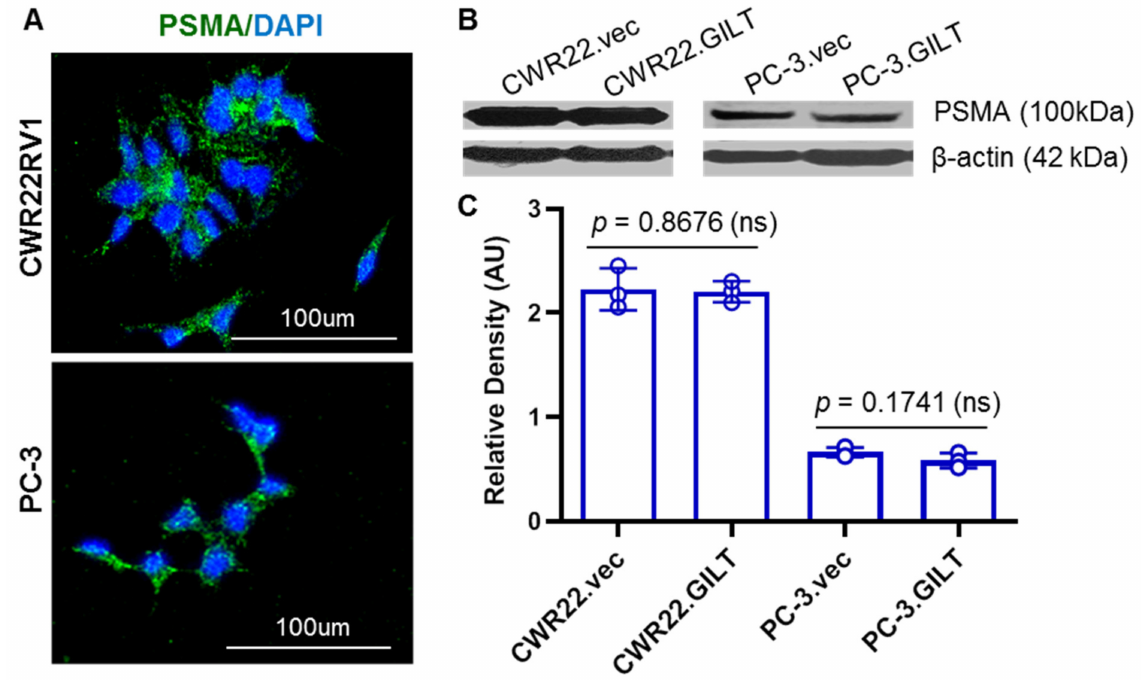
Figure 2. GILT insertion did not influence PSMA protein expression in human prostate cancer cells. ( A ) The expression of PSMA was tested in CWR22Rv1 and PC-3 prostate cancer cell lines by im- munofluorescent staining (green) with the anti-PSMA antibody, followed by confocal microscopy. ( B ) CWR22Rv1 and PC-3 cells transfected with either empty vector or GILT cDNA and analyzed by Western blotting for PSMA protein expression. β -actin was used as a loading control. ( C ) Densit- ometric analysis of protein bands obtained from CWR22Rv1.vec, CWR22Rv1.GILT, PC-3.vec, and PC-3.GILT showed no significant changes in PSMA protein expression following GILT transfection. Data are representative of three separate